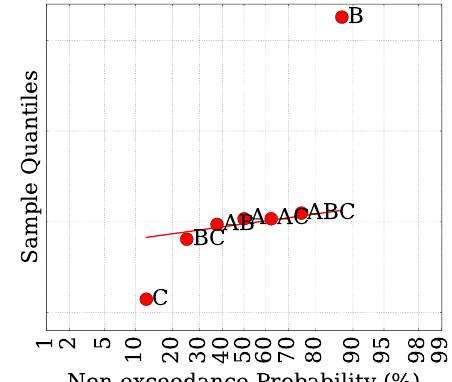
Figure 7: Average total thickness contrasts